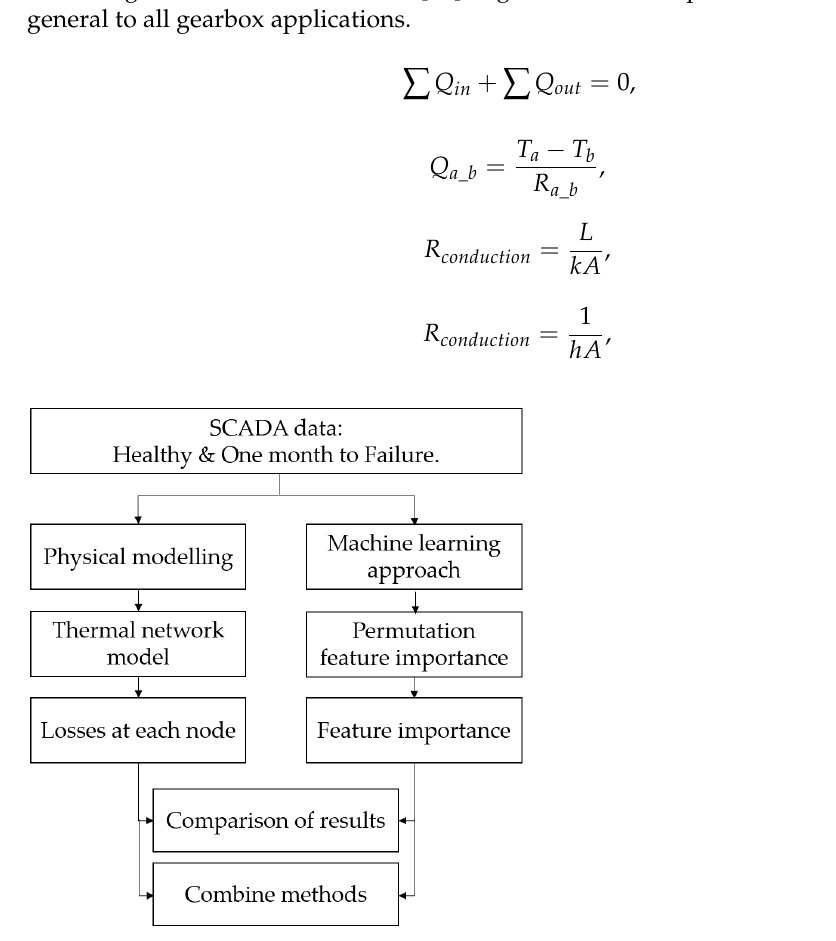
Figure 3. High-level methodology.